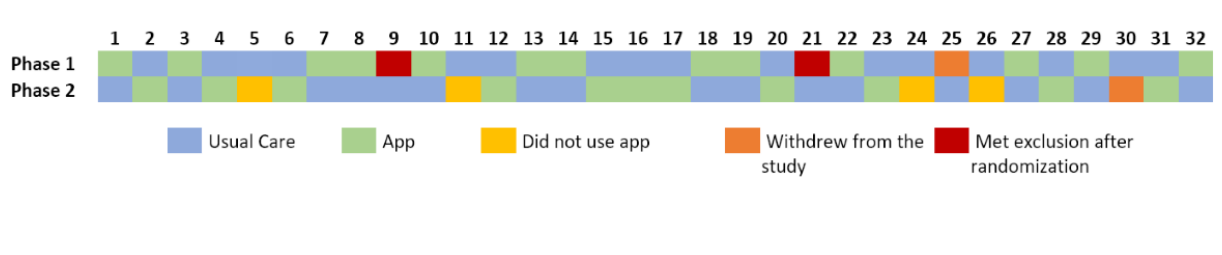
Figure 5. Representation of all patients recruited in the study, their randomization sequence, and app